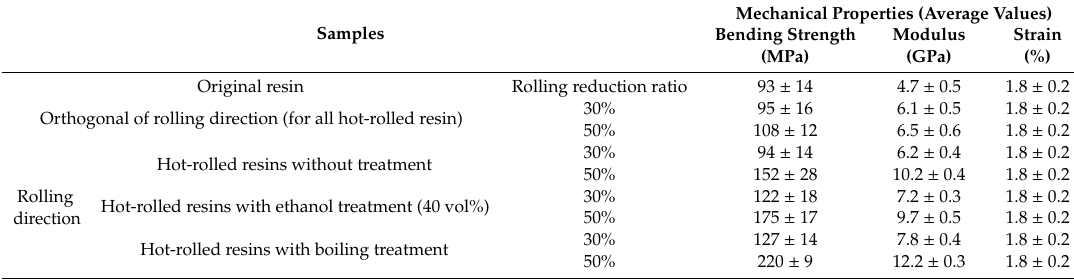
Table 2. The mechanical properties of the original RS resin samples and the hot-rolled silk resins in di ff erent rolling reduction ratios without and with di ff erent pretreatments. (The water content of all samples is fixed at around 2%–4%).